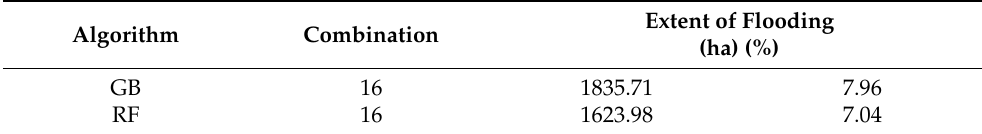
Table 11. Extent of flooding in the rainy